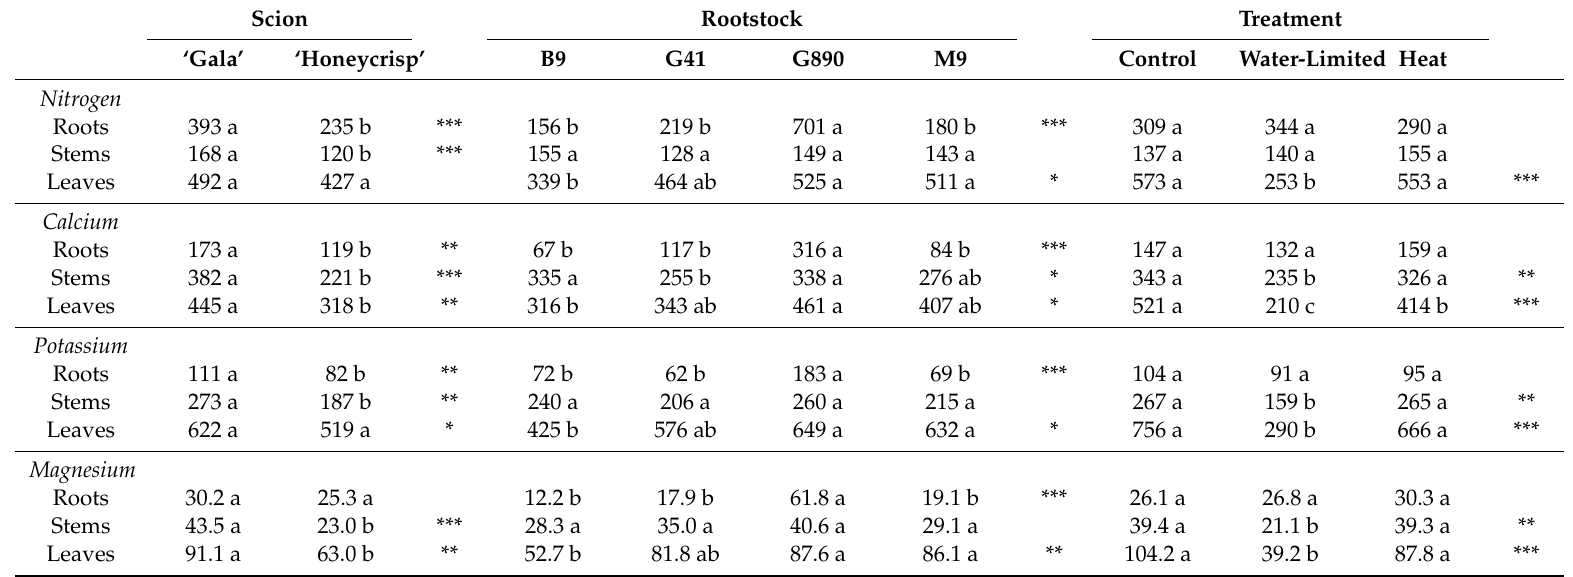
Table 3. Nitrogen, calcium, potassium, and magnesium content (mg) for roots, stems and leaves of ‘Gala’ and ‘Honeycrisp’ scion genotypes in combination with B9, G41, G890, and M9 rootstocks genotype grown in untreated control, water-limited, or elevated soil temperature treatments. Di ff erent letters denote significant di ff erences among columns determined using a Tukey’s mean separation test ( α = 0.05). ***, ** and * indicate significance in di ff erences among means at p -values < 0.0001, < 0.01 and < 0.05,